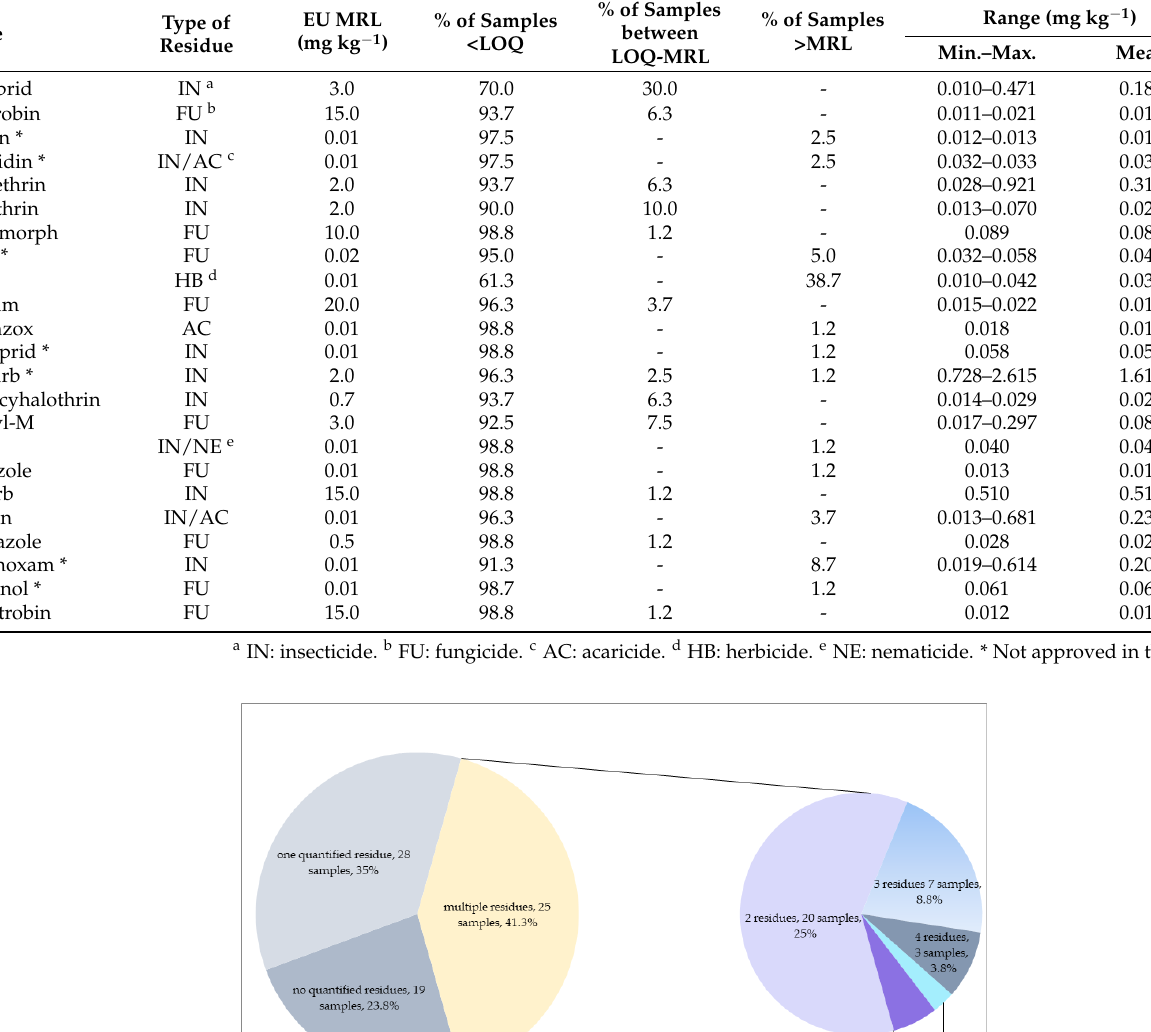
Table 3. The presence and quantification of pesticide residues in rocket.